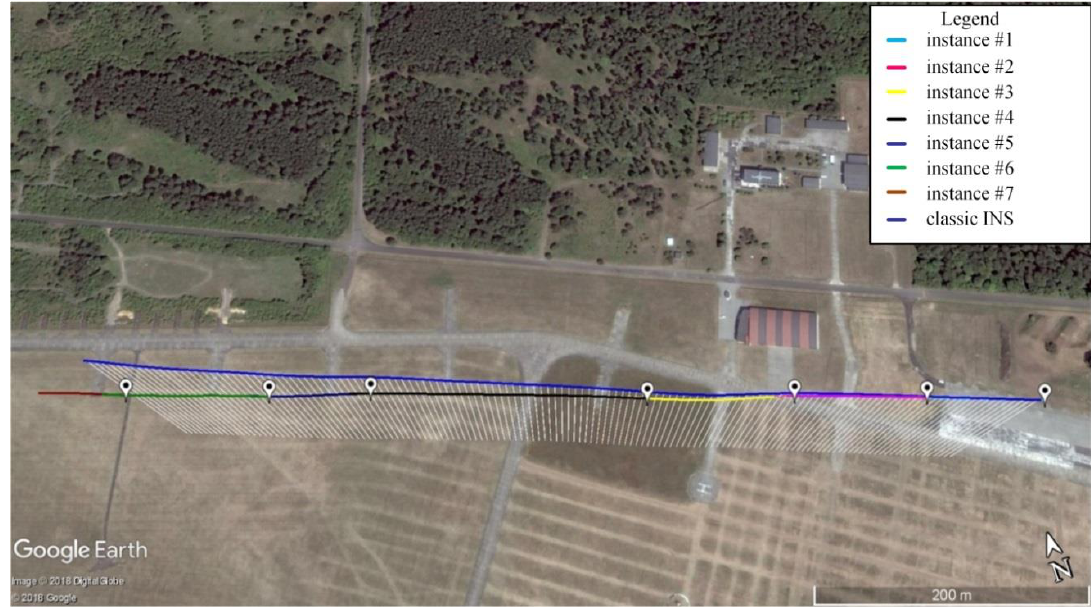
Table 3. Parameters of the quality of the selected SAR image.